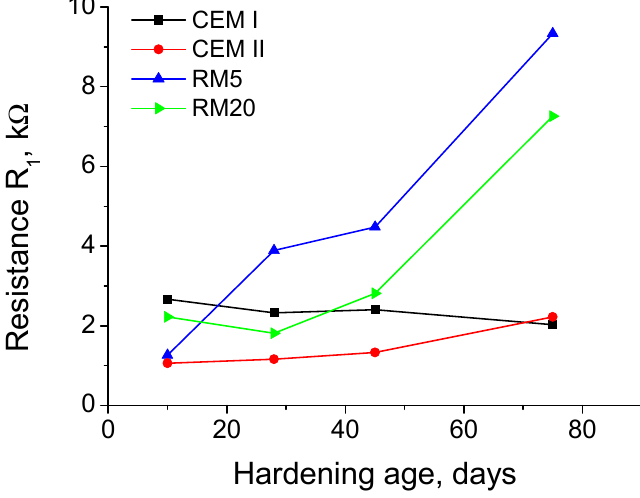
Figure 8. Results of impedance spectroscopy resistance R 1 for CEM I, CEM II, RM5 and RM20 mortars.